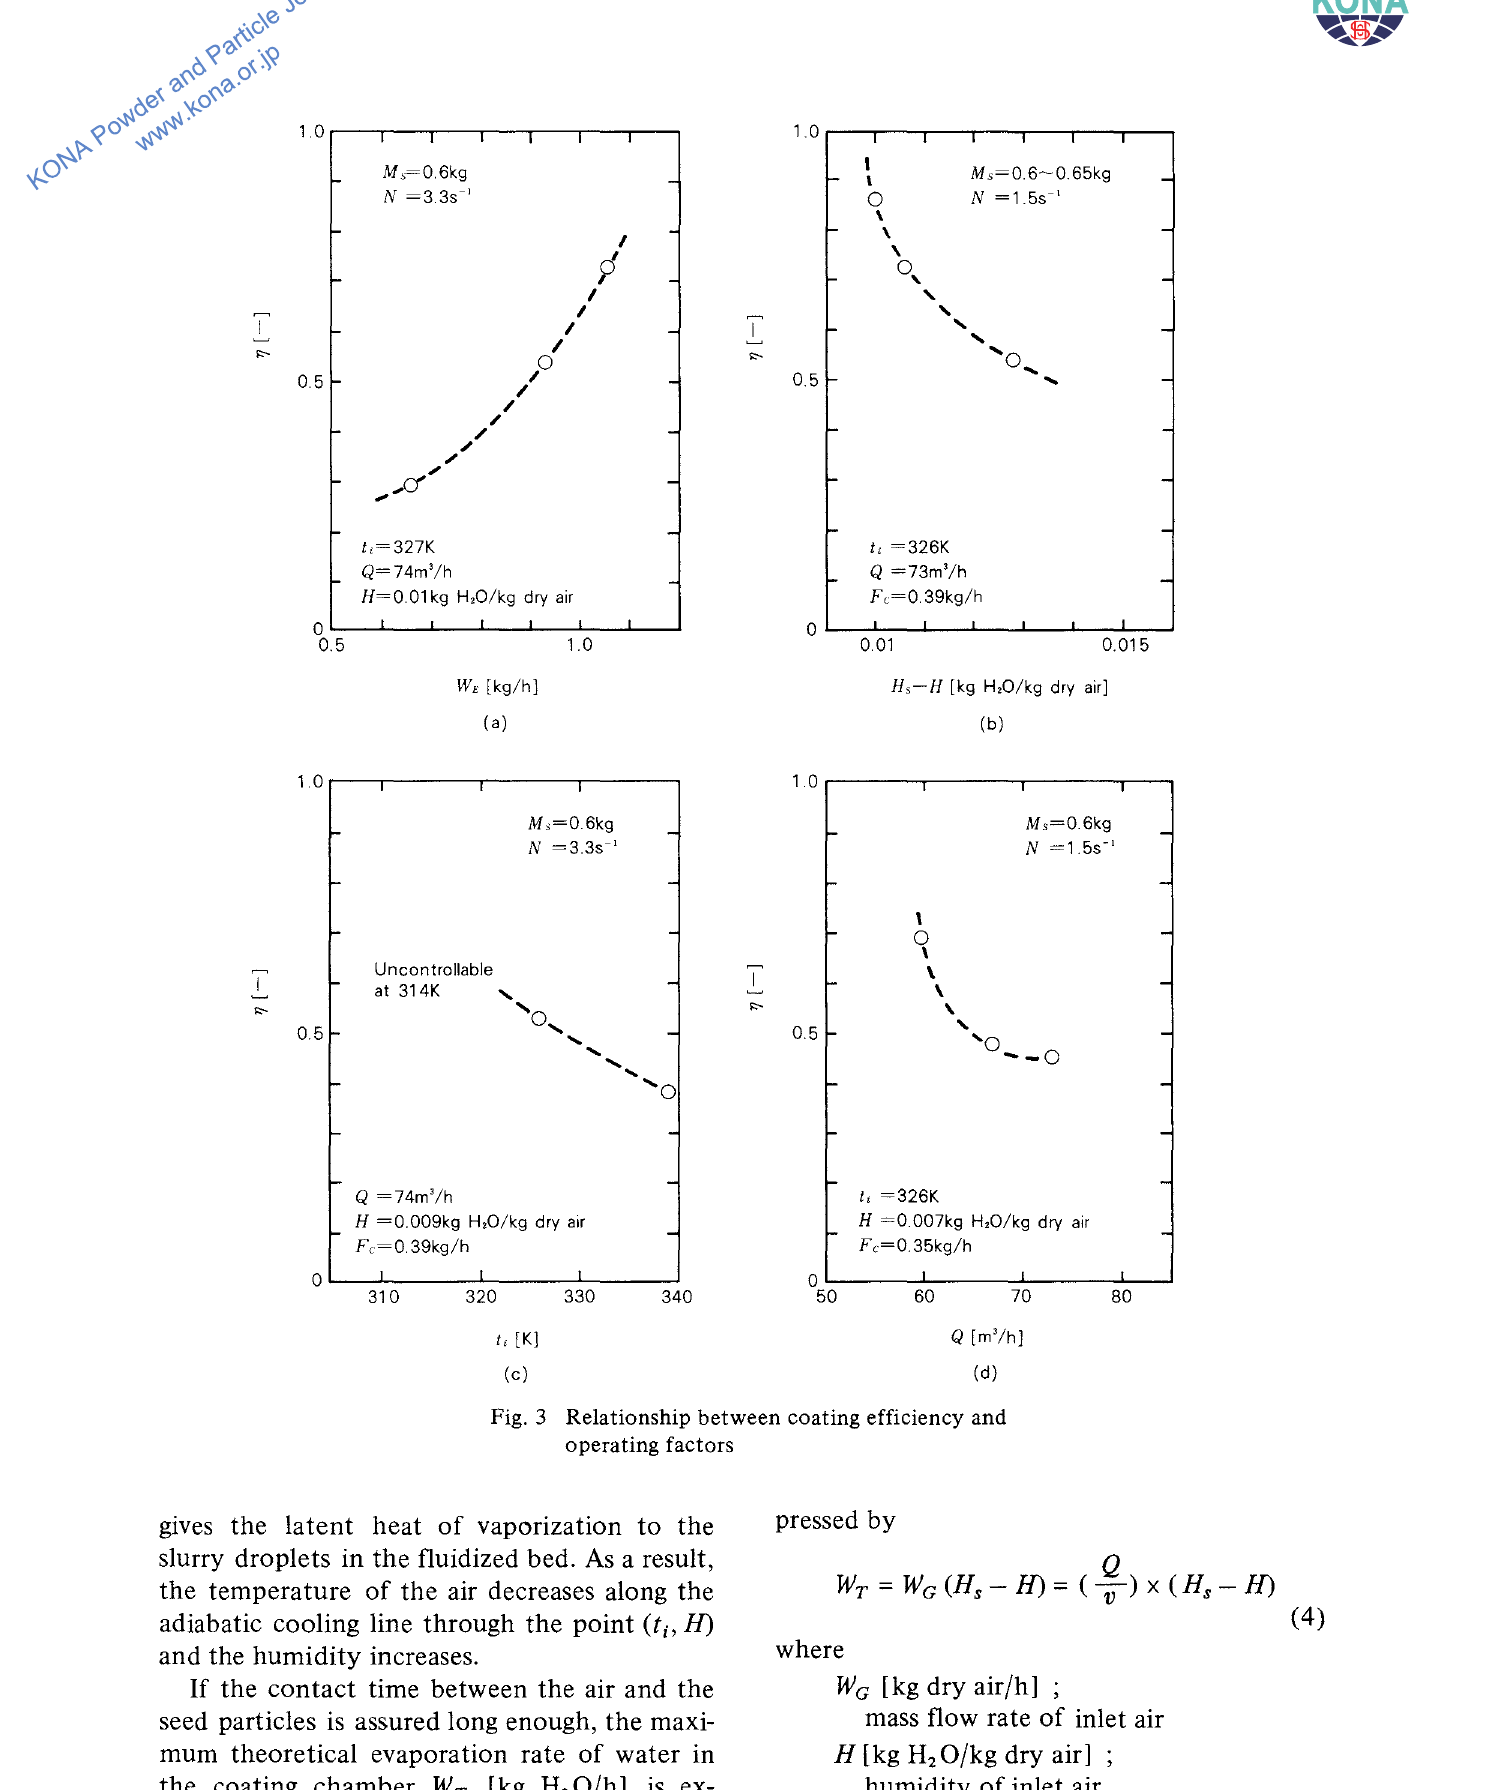
Fig. 3 Relationship between coating efficiency and operating